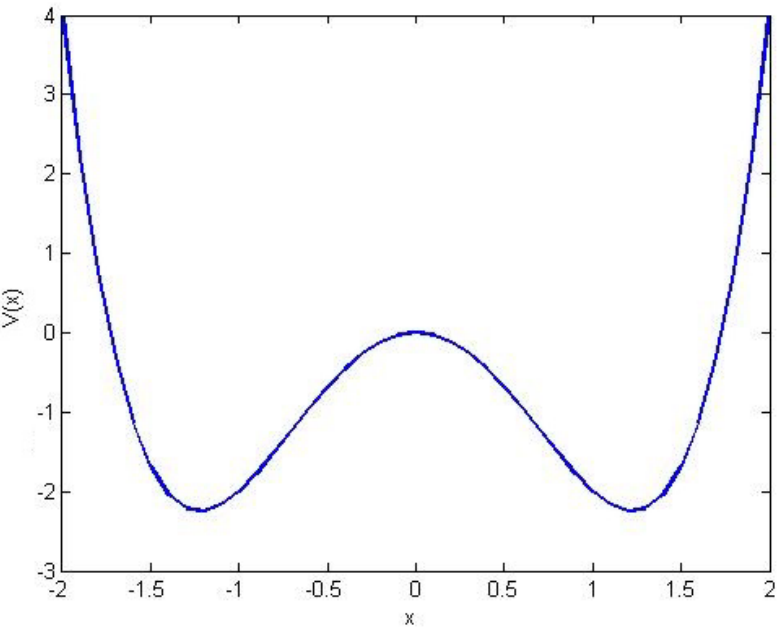
Figure 7. Variation of V ( x ) (Equation (17)) with x .